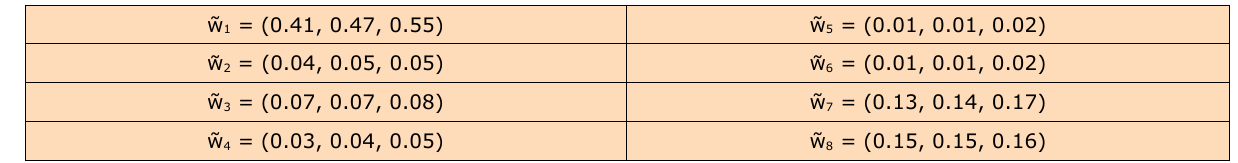
Table 10. value of fuzzy weights (w̃ i ) of hazard factors